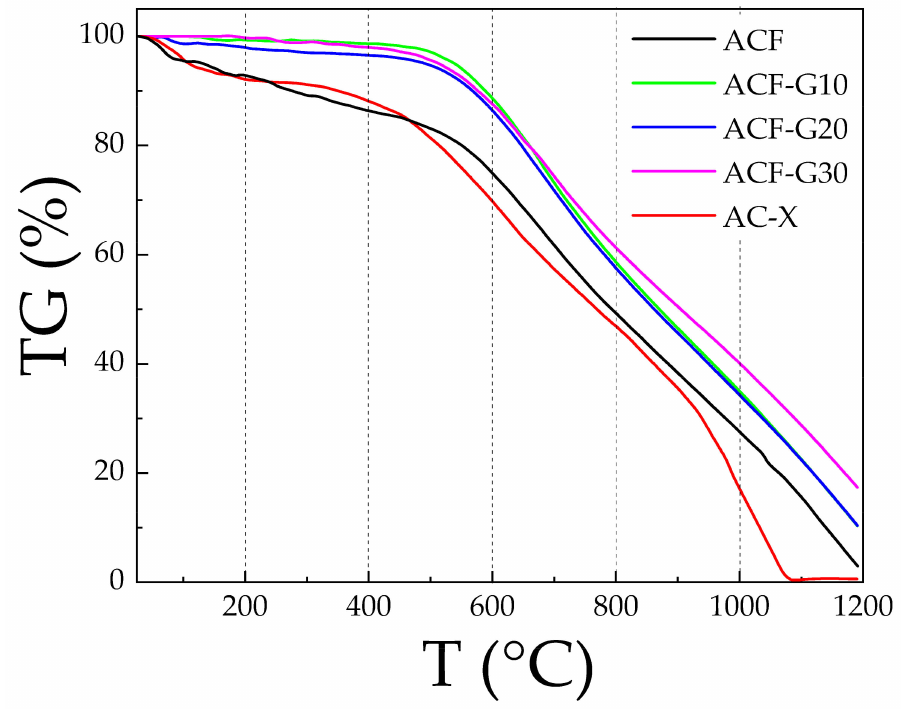
Figure 6. TGA curve of the carbon foams and activated carbon